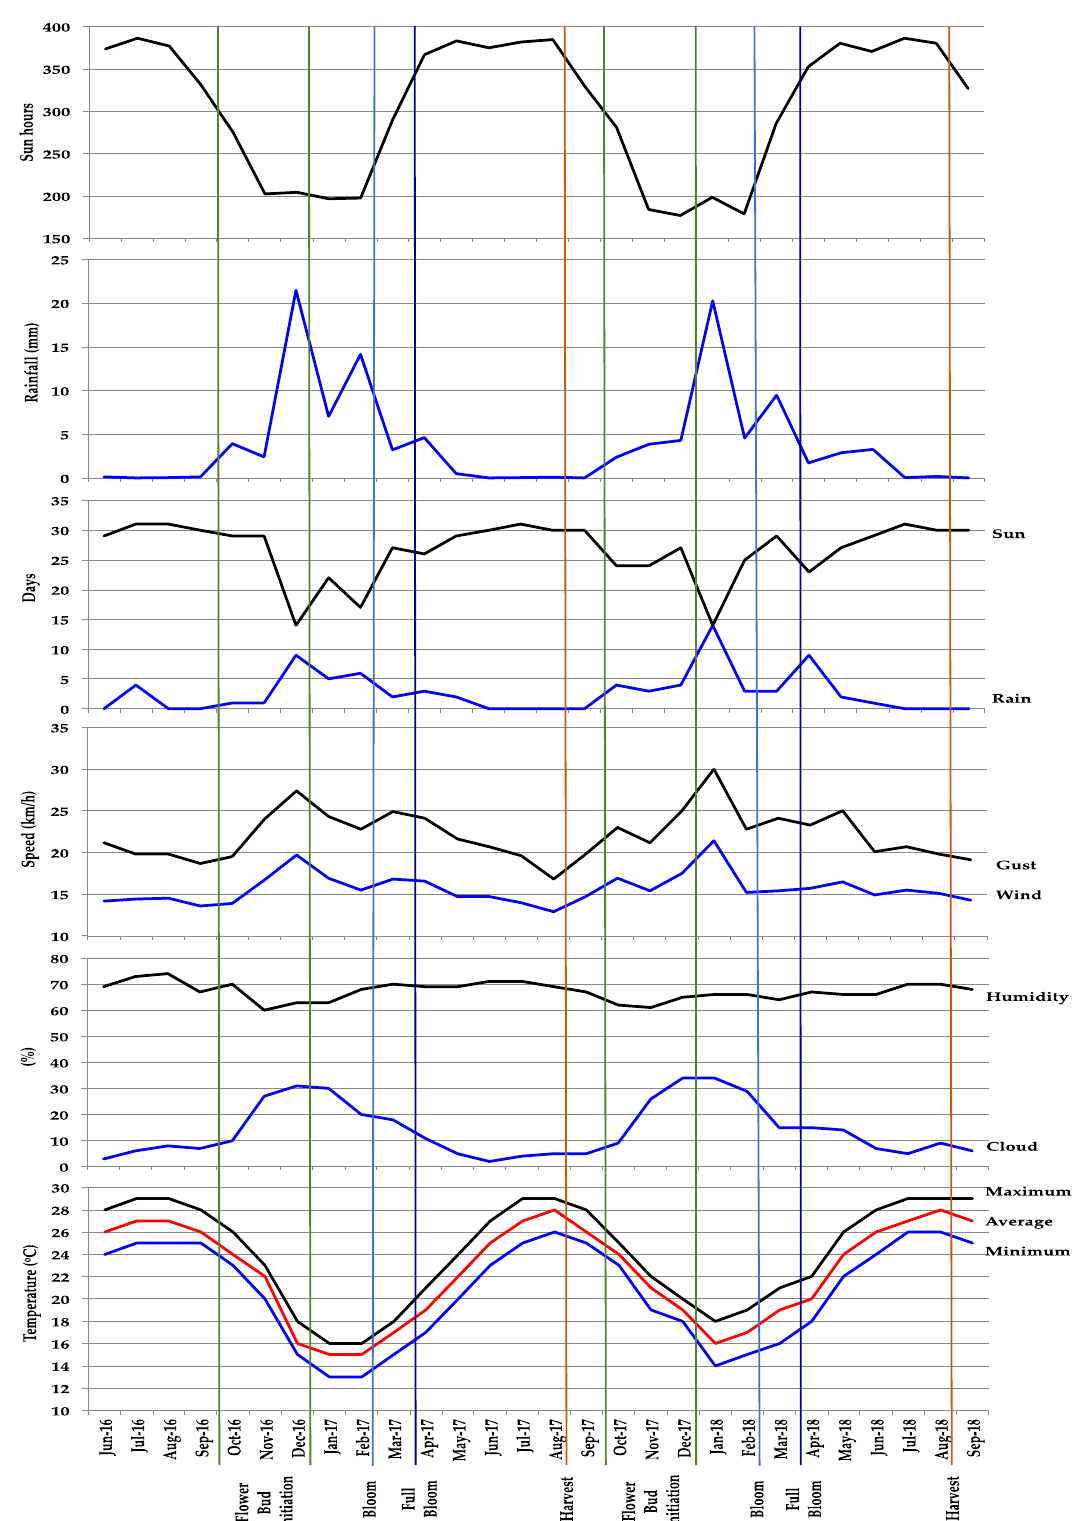
Figure 1. Fruiting phenology of “Ewais” mango trees in relation to weather of Damietta, Egypt.